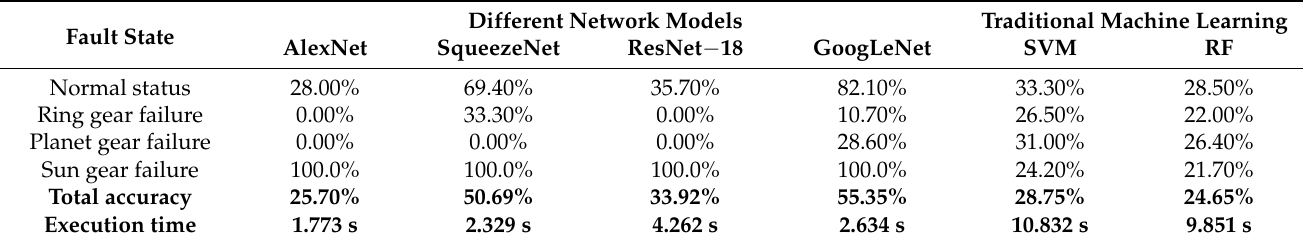
Table 8. Comparative analysis of fault diagnosis between different network models and traditional methods when CR =